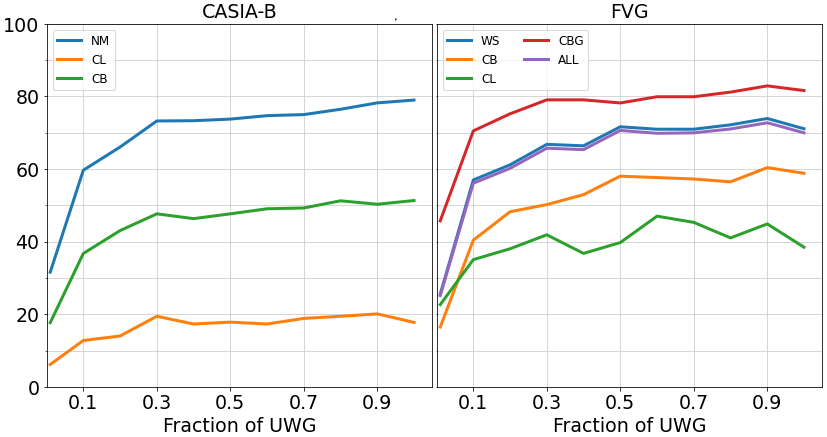
Figure 6. UWG dataset size influence over the transfer learning performance of WildGait on down- stream evaluation benchmarks. The network was pretrained on UWG, but not trained on CASIA-B or FVG. For CASIA-B, we show mean accuracy where the gallery set contains all viewpoints except the probe